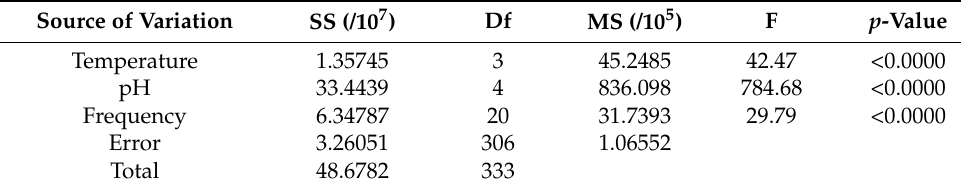
Table 16. Two-Way ANOVA results for the delay with selected data.